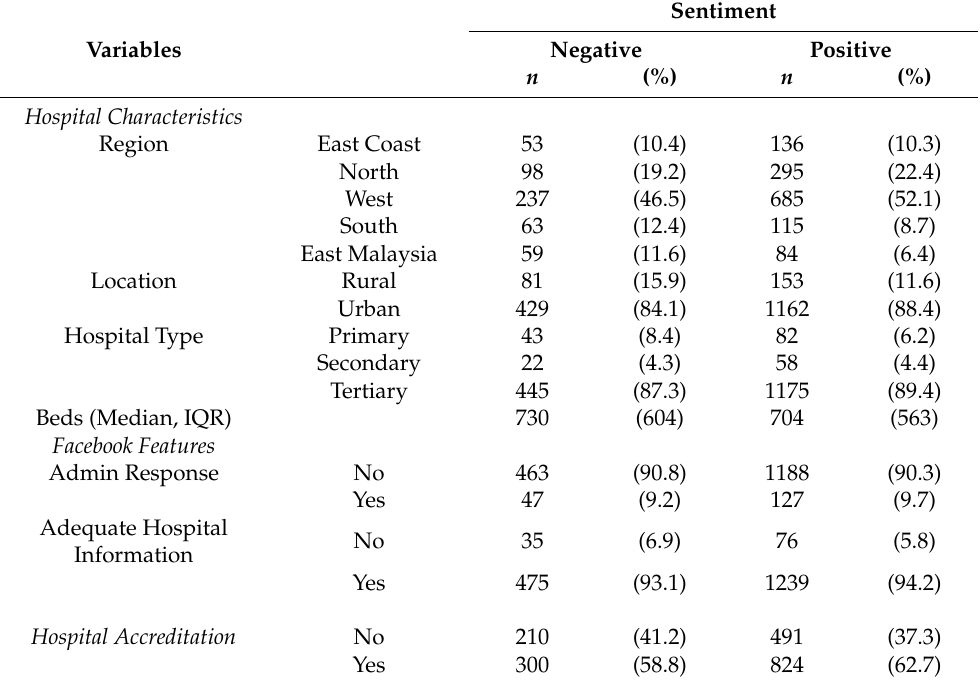
Table 5. Characteristics of Facebook reviews ( n =